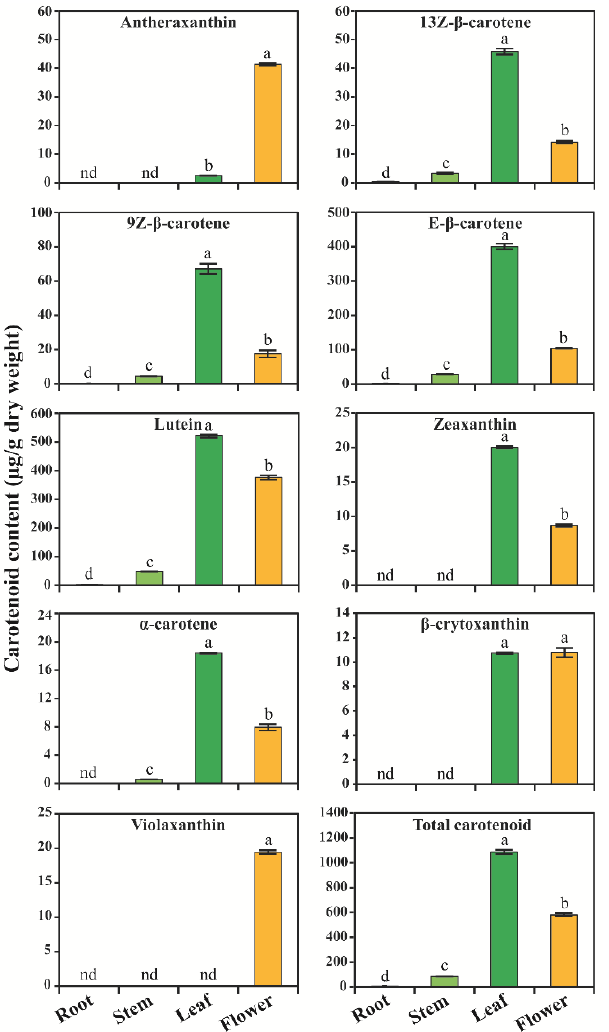
Figure 6. Carotenoid content in the different organs of Chelidonium majus . For HPLC analysis, samples were harvested from 3-month-old plants. Results are given as the means of triplicates ± standard deviation. Letters a–e denotes significant differences ( p < 0.05). nd: not detected.